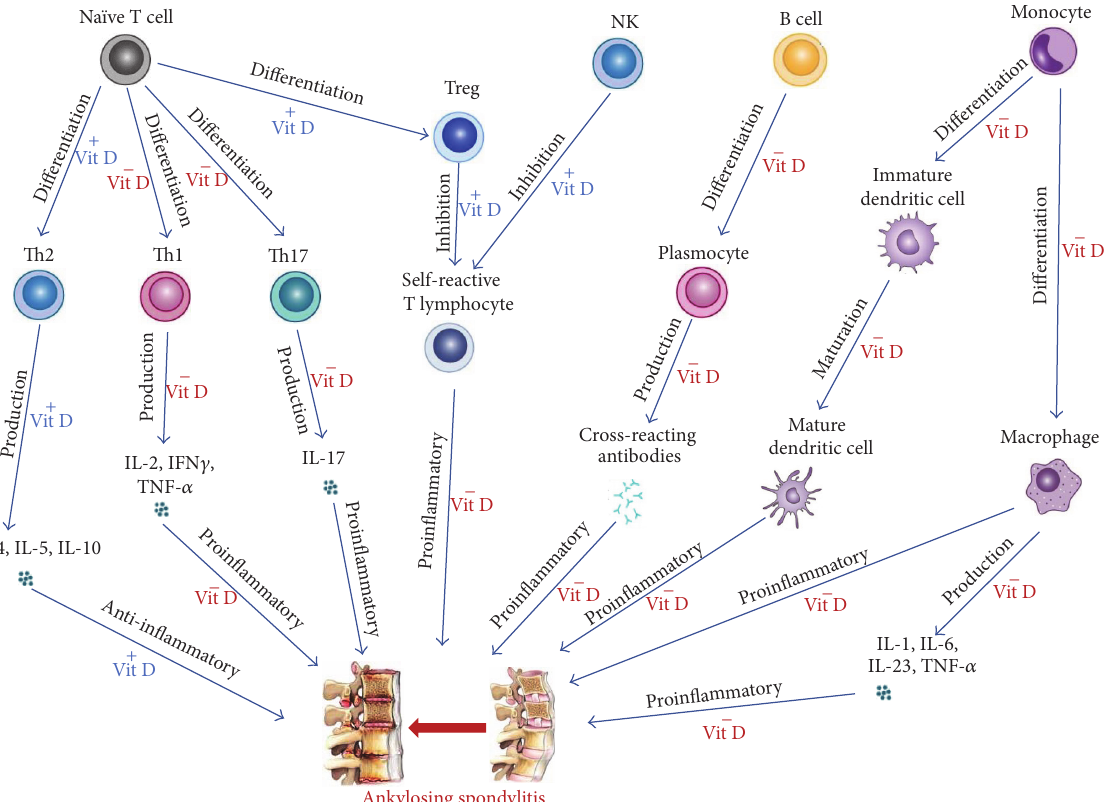
Figure 1: Vitamin D immunomodulatory activity influencing ankylosing spondylitis. +: stimulation by vitamin D (Vit D); − : inhibition by Vit D. Vit D can have effect on the na¨ıve T cell, the natural killer (NK) cell, the B cell, and monocyte hence putatively inhibiting ankylosing spondylitis pathogenesis. (I) Vit D may stimulate the na¨ıve T cell’s differentiation into T helper (Th) 2 with raised production of anti- inflammatory cytokines and into the T regulatory (Treg) cell, thus inhibiting the self-reactive T lymphocyte. Besides, Vit D may inhibit differentiation of the na¨ıve T cell into Th1 and Th17 with decreased production of proinflammatory cytokines. (II) Vit D may stimulate the NK celltoinhibittheself-reactiveTlymphocyte.(III)VitDmayinhibitdifferentiationoftheBcellintoplasmocyte,thusinhibitingtheproduction of cross-reacting antibodies. (IV) Vit D may inhibit monocyte-to-dendritic cell differentiation and monocyte-to-macrophage differentiation, withconsequentialreducedproductionofproinflammatorycytokines.IL:interleukin;IFN 𝛾 :interferongamma;TNF- 𝛼 :tumornecrosisfactor